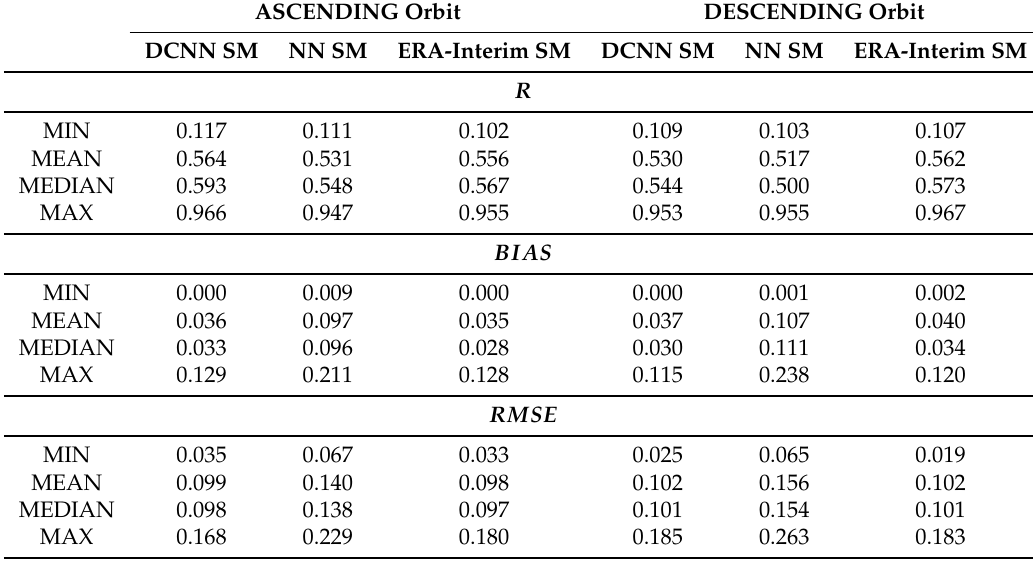
Table 1. The min, mean, median and max values of R , BIAS , RMSE between the time series of DCNN/NN SM and ERA-Interim SM against in situ measurements from SCAN sites in the testing phase during 1 January to 31 December 2016. Data from ascending and descending orbits are processed